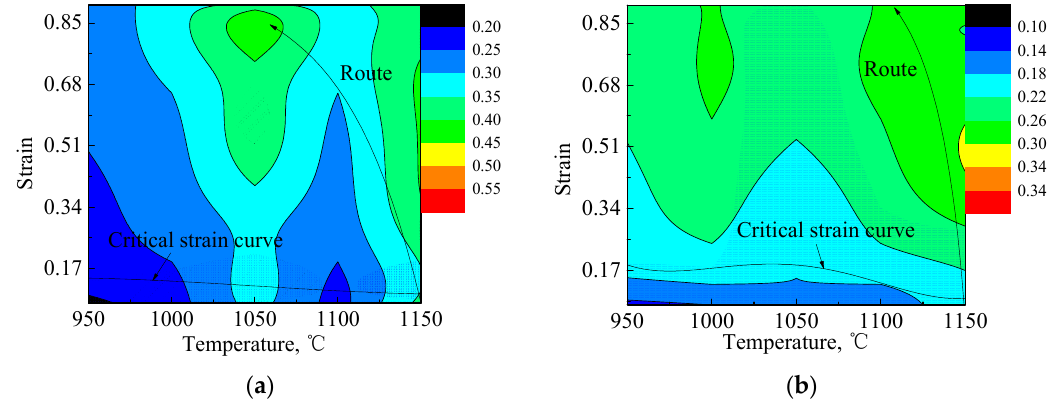
. ε . ε = 0.01 s ´ 1 ; and ( b ) = 0.1 s ´ 1